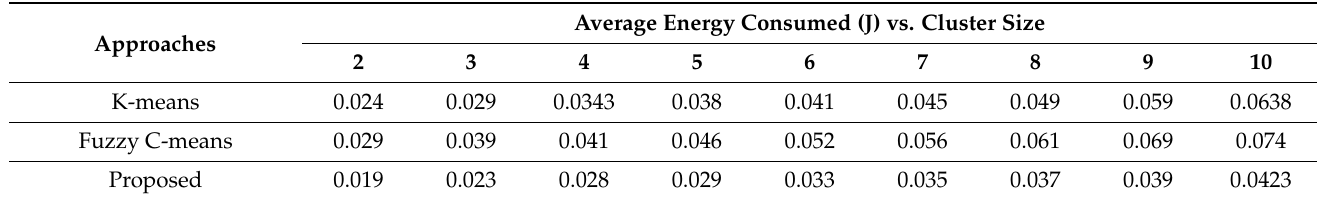
Table 2. Comparison of the average energy consumption of the proposed ASFO algorithm.